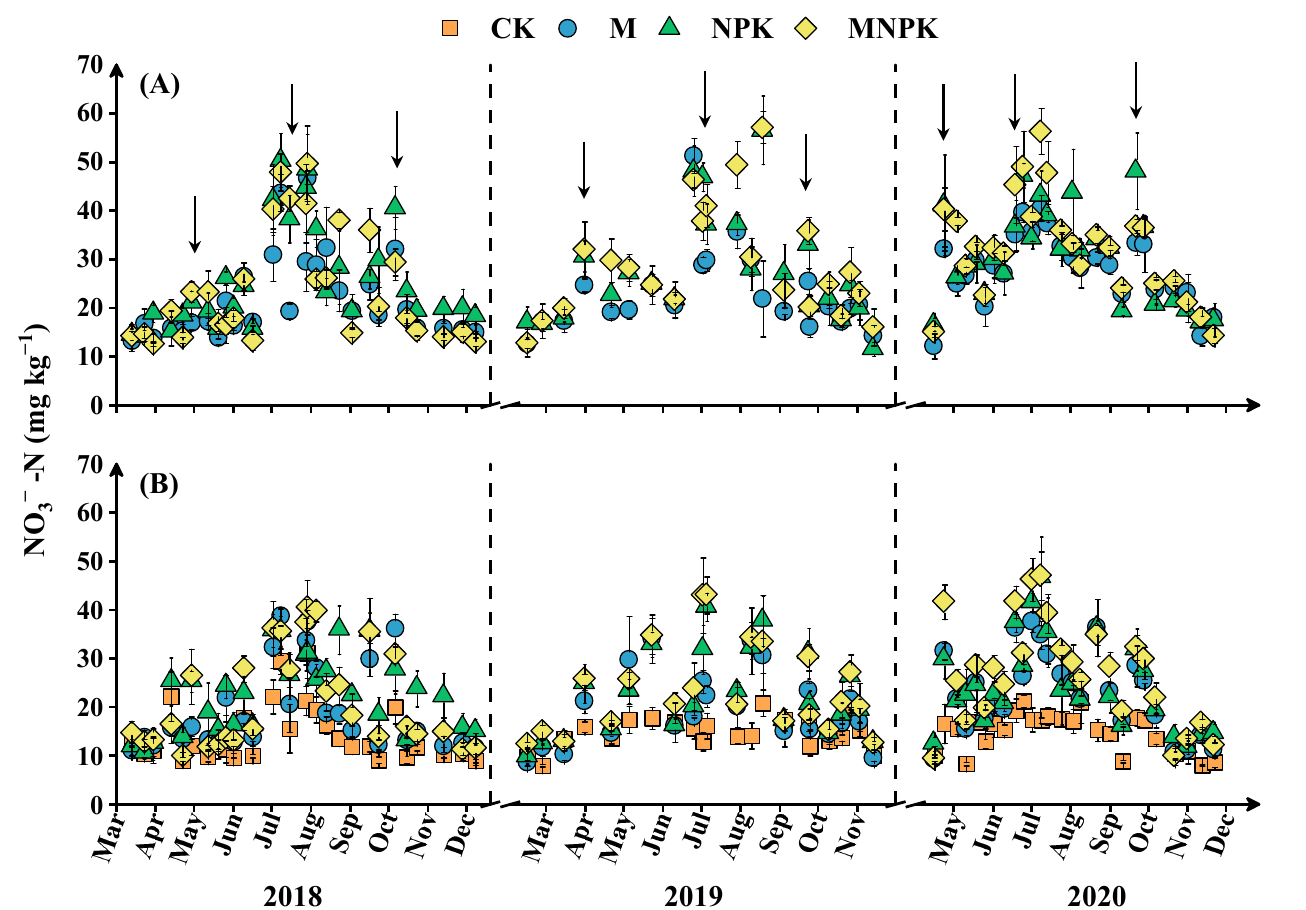
Figure 5. Seasonal dynamics of soil NO 3 − -N contents across all treatments from 2018 to 2020. ( A ) FD: fertilizer ditches, ( B ) BS: bare soil, CK: control, M: organic manure, NPK: chemical fertilizer, MNPK: chemical fertilizer combined with organic manure. The data points indicate the means of the four replicates, and the error bars indicate the standard error (±SE). The black arrows represent the date of fertilizer application.